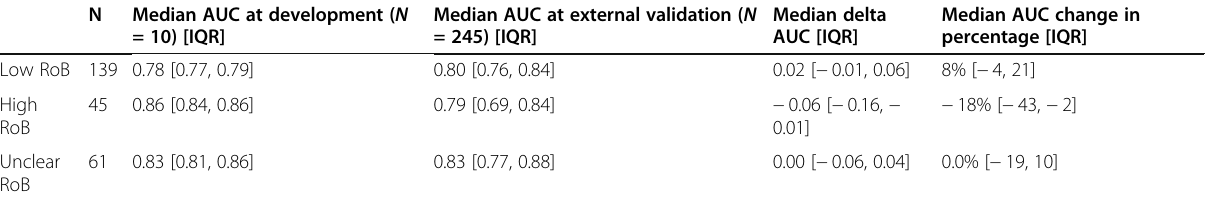
Table 3 The median AUC at development and external validation and the absolute and percentage change between development AUC and validation AUC stratified by risk of bias (RoB) of model development studies based on the original PROBAST